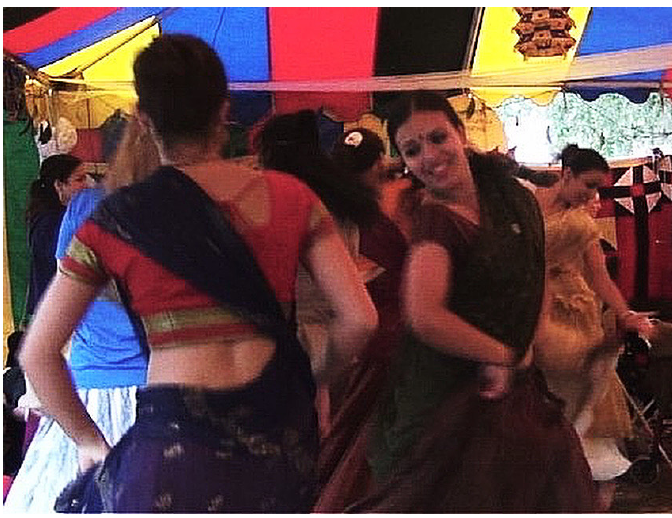
Figure 9. Dancing to Jahnavi’s Kirtan .